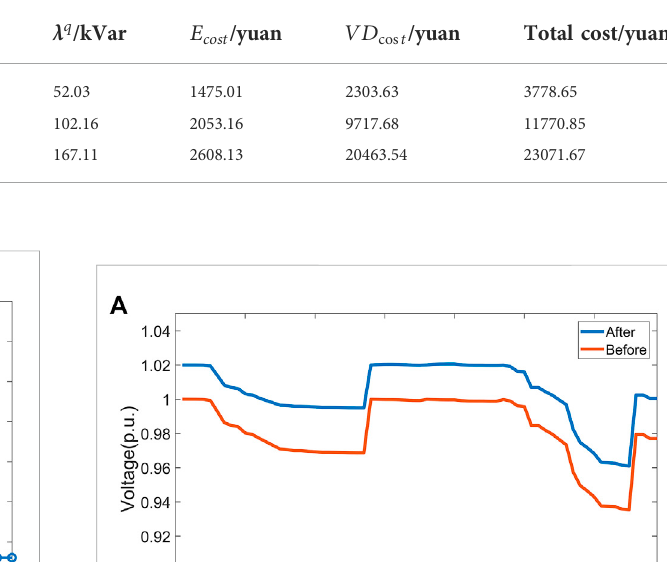
TABLE 1 Operation cost of distribution network in scenario 1